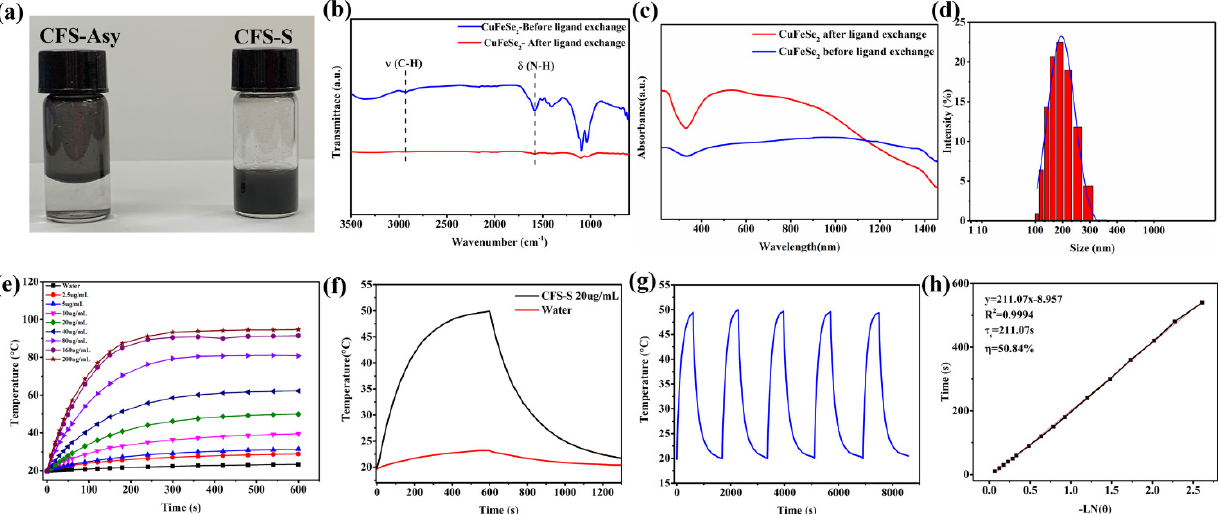
Figure 2. ( a ) Synthesized CuFeSe 2 nanosheets (1 mg/mL) and ligand-exchanged CuFeSe 2 (1 mg/mL). ( b ) FTIR spectra. ( c ) UV–Vis–NIR spectra of the synthesized CuFeSe 2 nanosheets and ligand-exchanged CuFeSe 2 . ( d ) Hydrodynamic diameters of CFS-S. ( e ) Photothermal heating curves of CFS-S aqueous solutions in different concentrations (i.e., 0, 5, 10, 20, 40, 80, and 160 µg/mL) irradiated by an 808 nm laser (1 W/cm 2 , 10 min). ( f ) Heating and cooling curves of CFS-S solution (20 µg/mL) and pure water irradiated with an 808 nm NIR laser for 10 min and then naturally cooled to room temperature. ( g ) Temperature plot of 20 µg/mL CFS-S aqueous solution irradiated by an 808 nm laser (1.0 W/cm 2 ) for five on–off cycles. ( h ) Linear time data versus ln ( θ ) obtained from the cooling period with laser off.